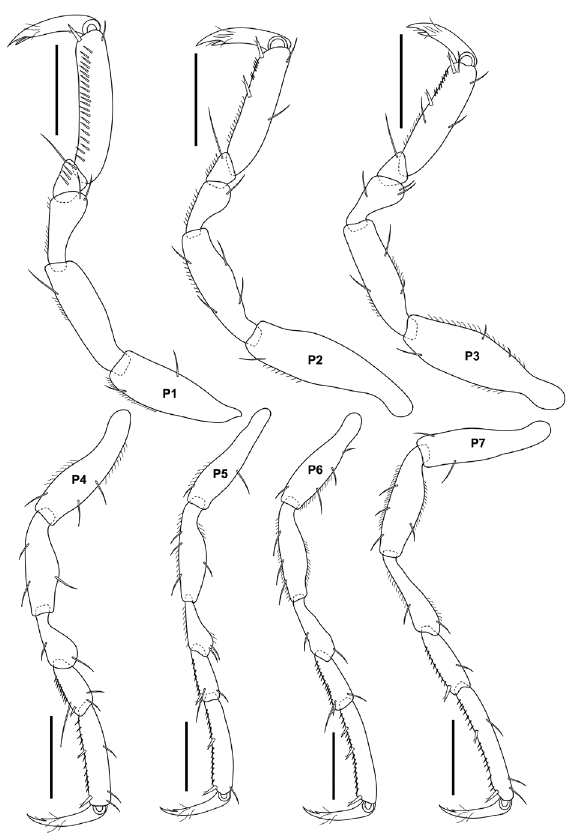
Figure 4. Eisothistos tiomanensis sp. n. All scales represent 0.1